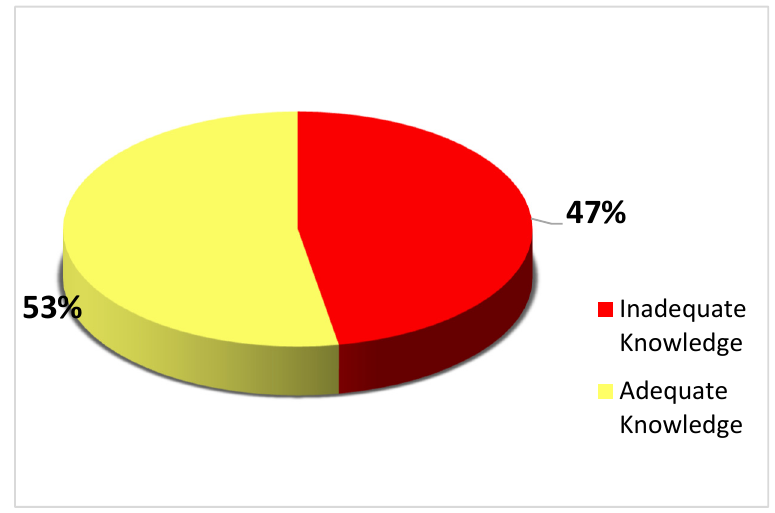
Figure 1. Knowledge score of participants.